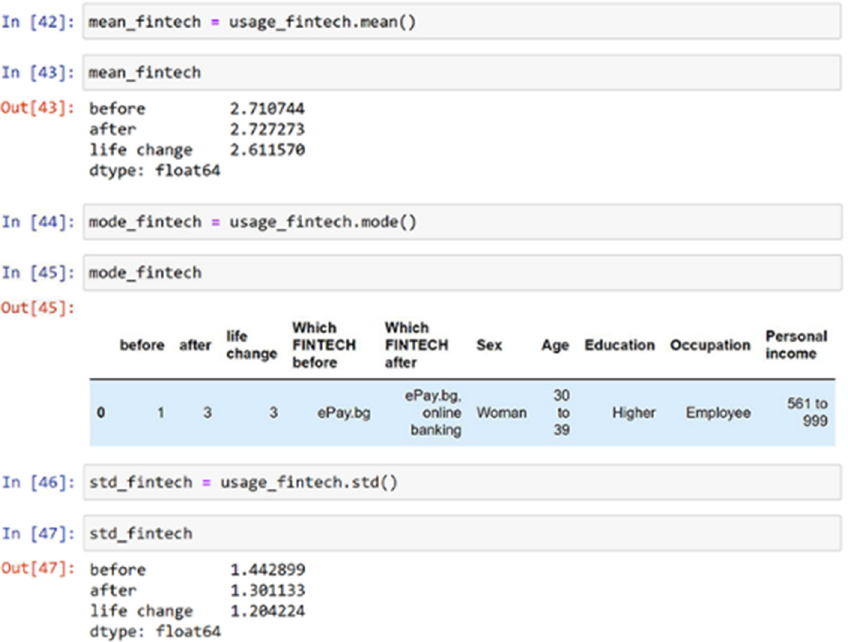
Figure A6. Mean, standard deviation, and mode of FINTECH usage calculated using Python via Jupyter Notebook. Source: own research.